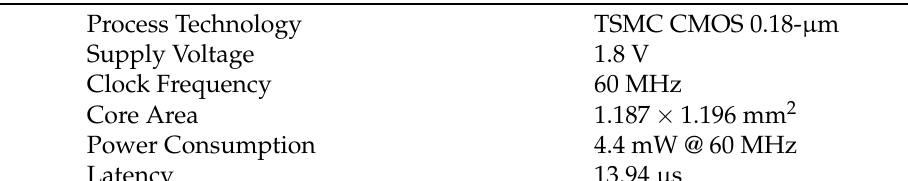
Table 4. Chip Characteristics of the proposed CNN accelerator